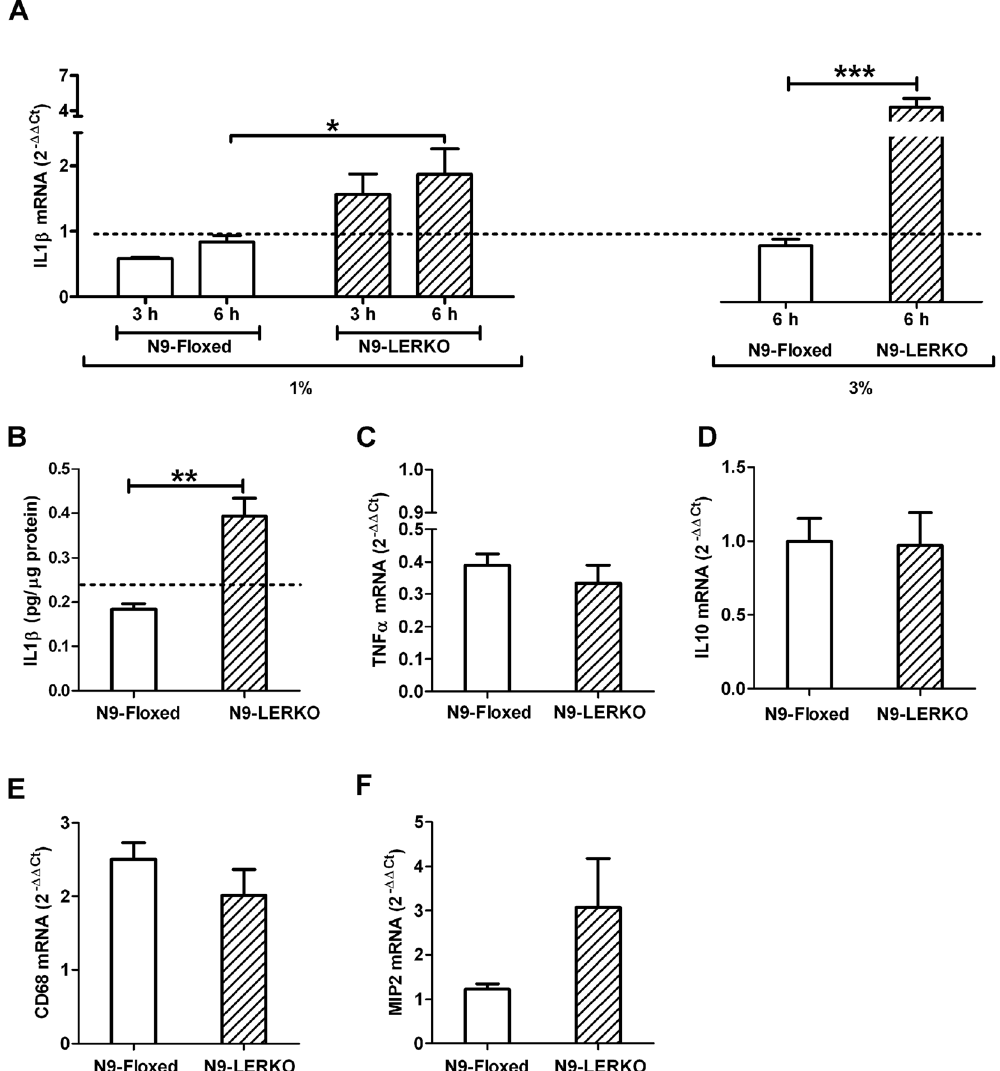
Figure 4. Plasma of LERKO mice induced IL1 β production in N9 microglia cells while TNF α , MCP1, MIP2 and IL10 mRNAs are unaffected. IL1 β mRNA measured by Real Time PCR in N9 cells treated with 1% or 3% of mouse plasma of floxed and LERKO mice in E for 3 and 6 hours. ( A ). IL1 β protein content in cell lysate from N9 cells treated with 3% of mouse plasma of floxed and LERKO mice in E for 6 hours ( B ), TNF α mRNA ( C ), IL10 mRNA ( D ), CD68 mRNA ( E ), MIP2 mRNA ( F ) measured by Real Time PCR in N9 cells treated with 3% of mouse plasma of floxed and LERKO mice in E for 6 hours. The dotted line represents the value of untreated N9 cells. Data shown are the combined results of 2 separate experiments (Fig. 4A,C,D and F: n = 4 wells/group/ exp, Fig. 4B: n = 2 wells/group/exp), all data are represented as mean ± SEM. The dotted lines represent the values of untreated cells. Figure 4A: * P < 0.05, one-way ANOVA followed by Bonferroni post hoc test, DF = 1, F = 11.10, p = 0.0088, N9-LERKO vs N9-SYN - treatment with 1% plasma, DF = 1, F = 0.85, p = 0.3795 3 h vs 6 h – treatment with 3% plasma, *** p < 0.0001, DF = 23, t = 5.646, two-tailed unpaired t-test, N9-LERKO vs N9-SYN – 3% treatment. Figure 4B: ** p = 0.0027, DF = 5, t = 5.516, two-tailed unpaired t-test. Figure 4C–F: no significant difference was found between the two experimental groups by two-tailed unpaired t-test, Fig. 4C: p = 0.3899, DF = 23, t = 0.8764, Fig. 4D: p = 0.2541, DF = 18, t = 1.178, Fig. 4E: p = 0.2541, DF = 9, t = 1.178, Fig. 4F: p = 0.9218, DF = 23, t =